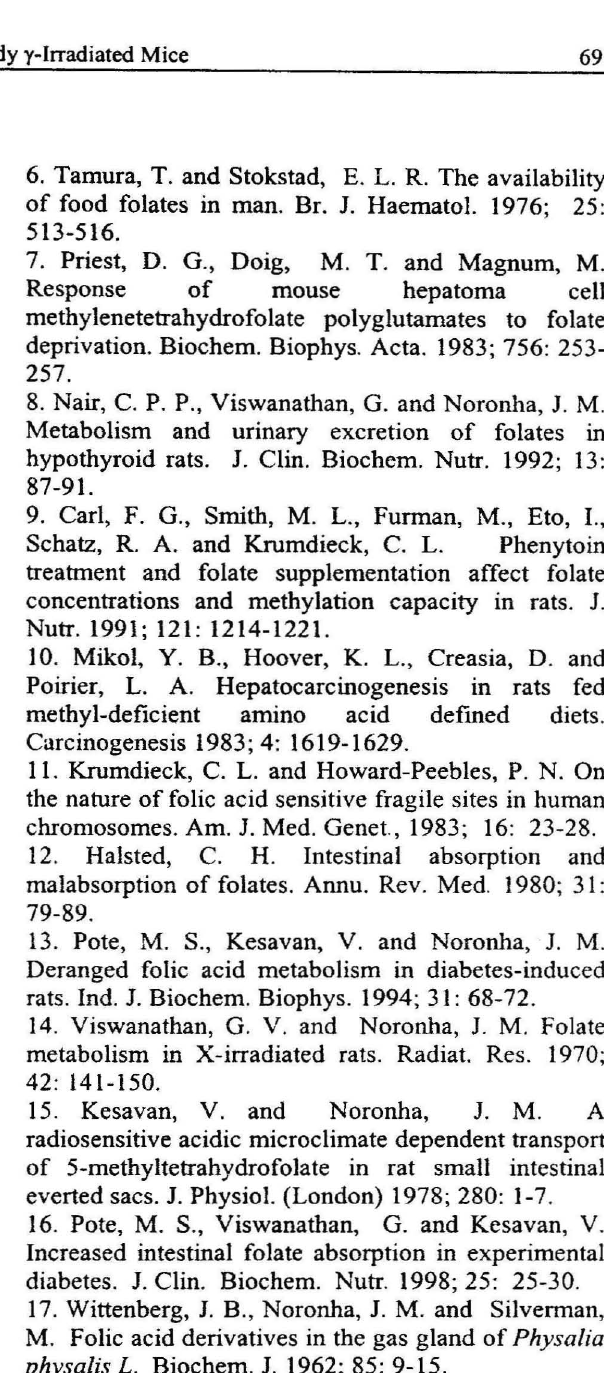
Table 5. Release of tyrosine in irradiated mouse